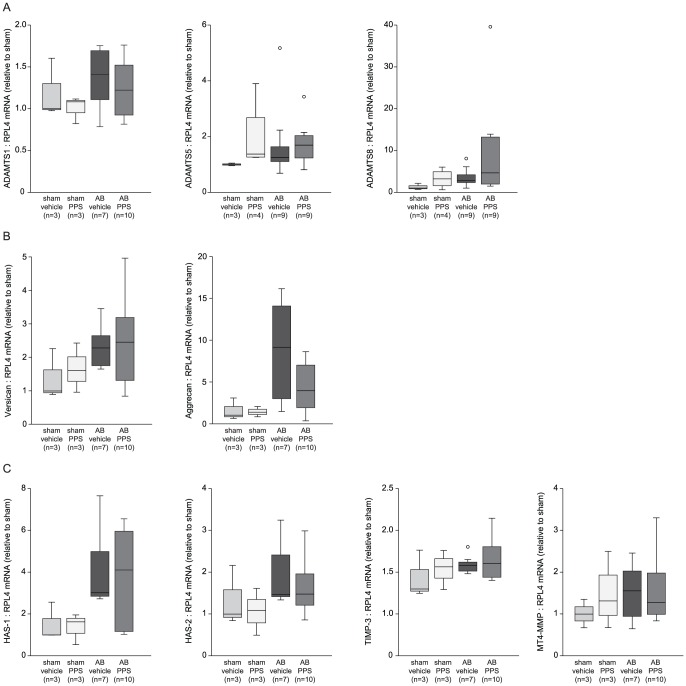
Myocardial mRNA levels after PPS treatment in rats after aortic banding.Myocardial mRNA expression of ADAMTS1, -5, -8 (A), versican, aggrecan (B), HAS-1, -2, TIMP-3, and MT4-MMP (C) in rats treated with PPS (n = 9 or 10) or vehicle (n = 7 or 9) six weeks after AB, and sham-operated rats treated with PPS (n = 3 or 4) normalized to the reference gene ribosomal protein L4 (RPL4) and relative to vehicle-treated sham (n = 3). The bars represent median levels and the error bars the 75th percentile. *p<0.05. HF, heart failure, HA, hyaluronic acid.